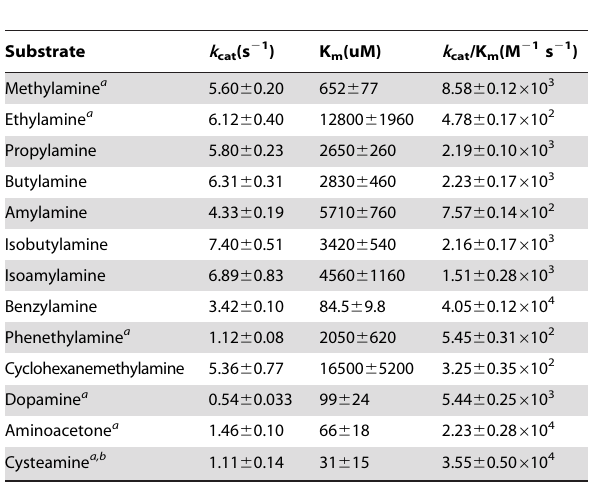
Table 2. Human AOC3 substrate kinetic profile.